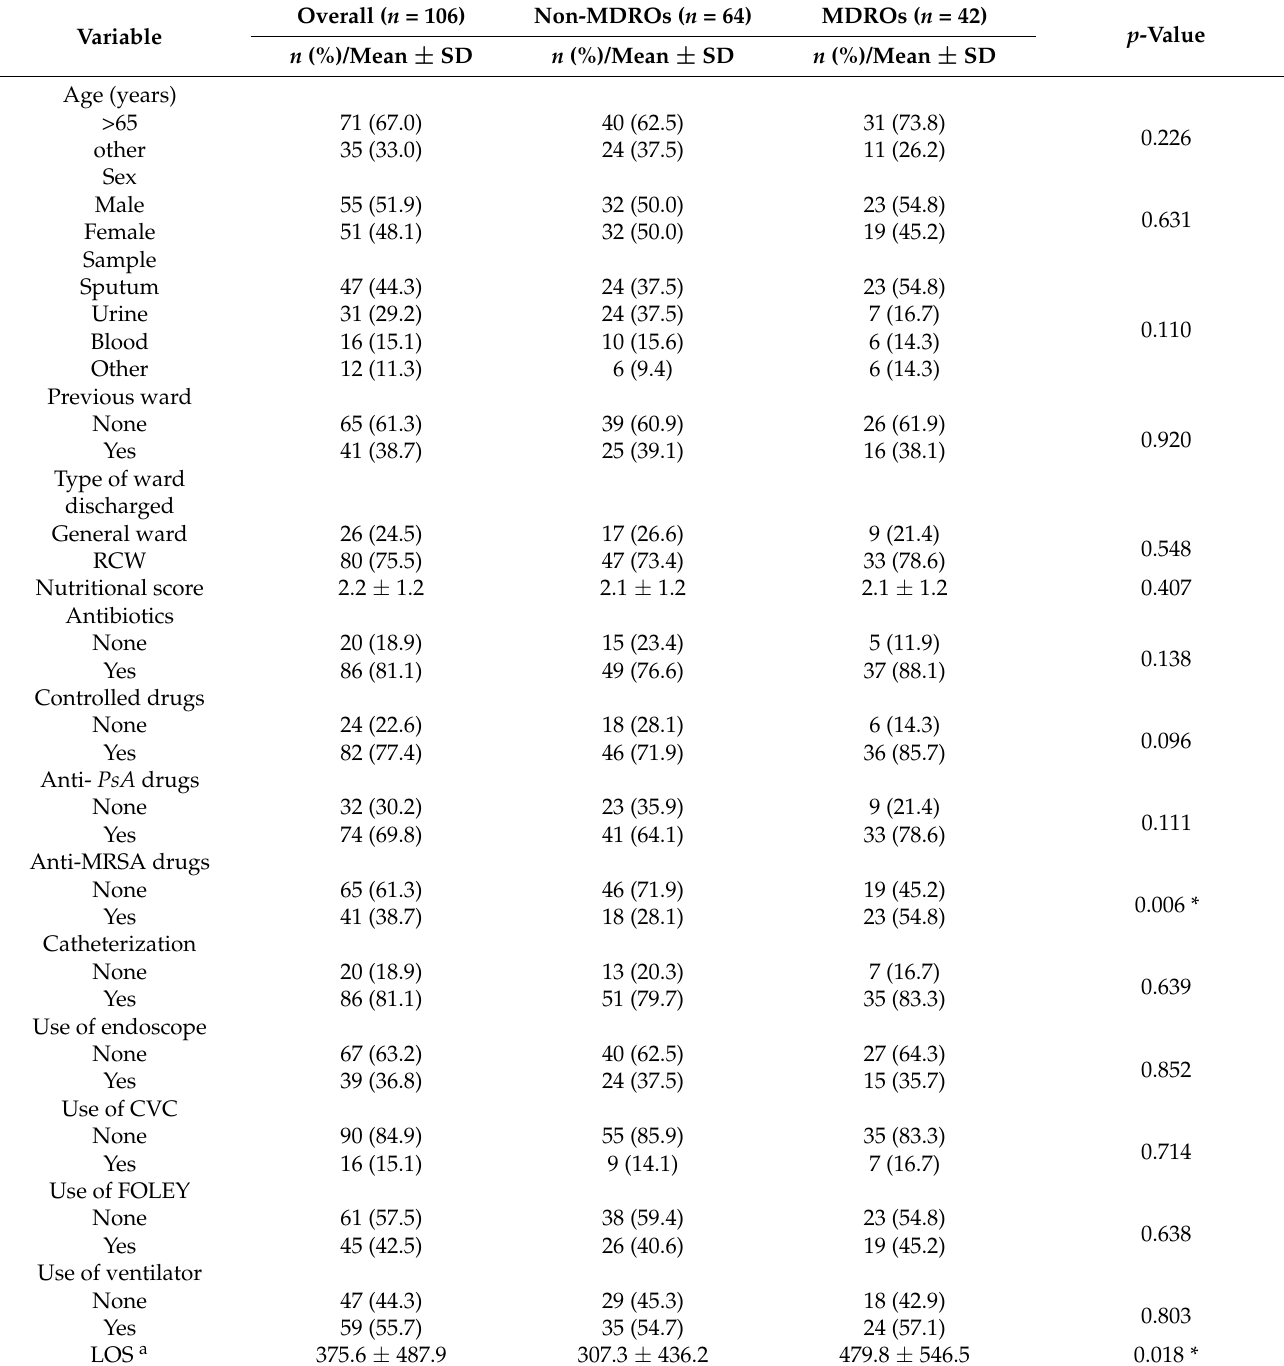
Table 1. Descriptive statistical analysis of risk